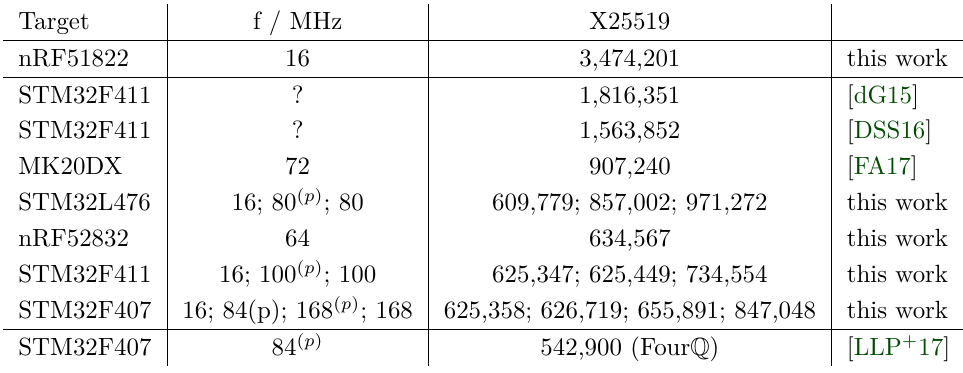
Table 5: Speed of X25519 scalar multiplication (Four Q ) (on different targets, clock and memory configurations). The timings marked with ( p ) were obtained with enabled flash pre-fetch engines which increase current consumption.